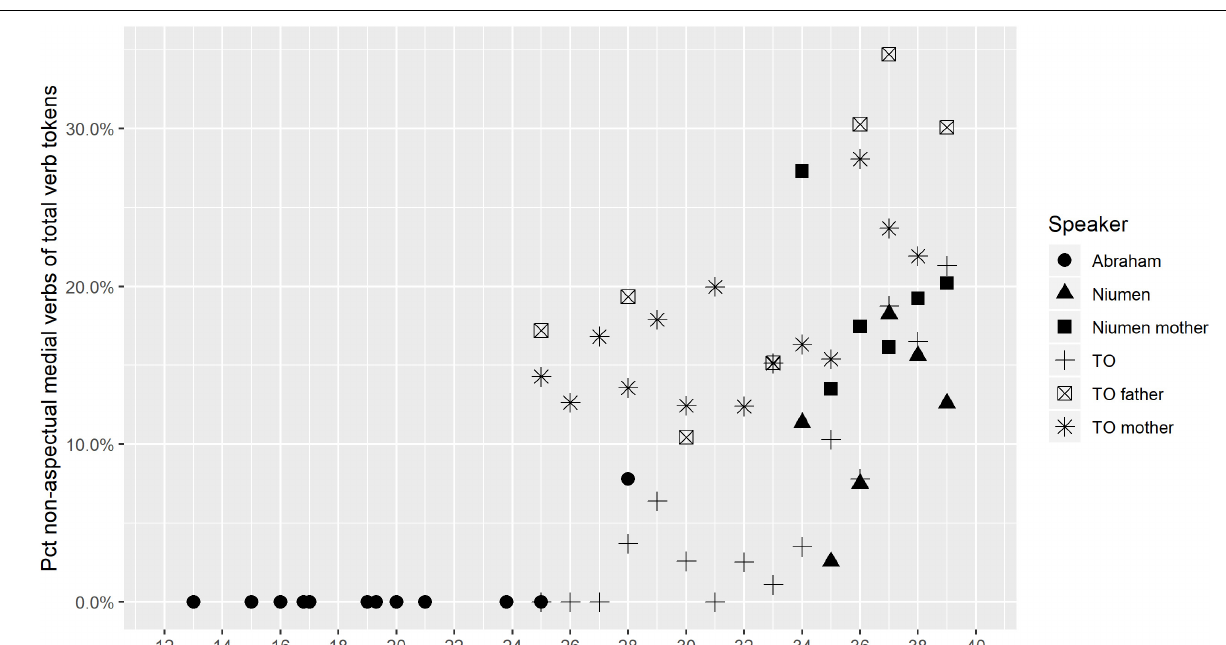
on 33.3–51.0% of Niumen’s non-aspectual medial verbs, and 25.0–85.7% of TO’s non-aspectual medial verbs. Niumen’s use of DS marking between 2;11 and 3;3 could show a slight upward